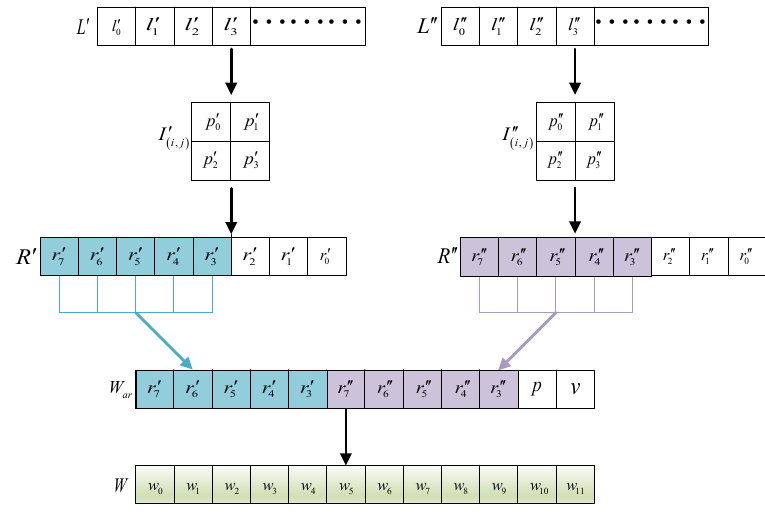
Figure 6. Watermark generation